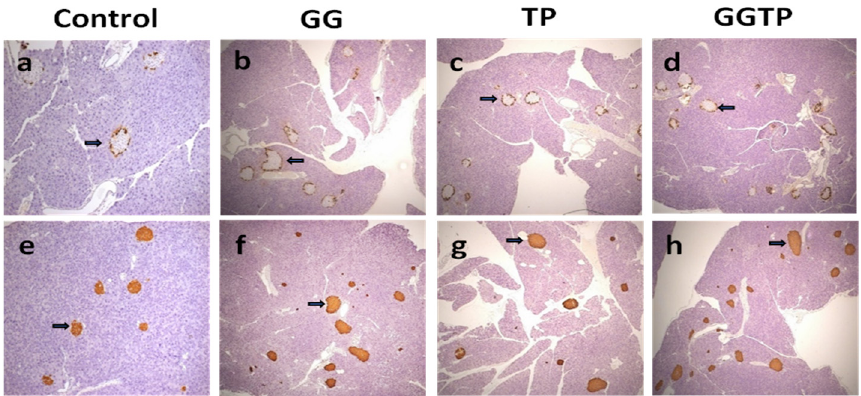
Figure 1. Effect of geranylgeraniol (GGOH) and green tea polyphenols (GTP) on immunohistochemical analysis of pancreatic tissue. Pancreatic tissue sections collected from mice fed HFD ( a , e ), High-fat-diet (HFD) only (control group), HFD supplemented with 400 mg GGOH/kg diet (GG group, ( b , f )), HFD supplemented with 0.5% GTP in drinking water (TP group, c , g ), and HFD supplemented with GGOH and GTP (GGTP group, ( d , f )) were immunostained for glucagon ( a – d ) or insulin ( e – h ) and counterstained with hematoxylin. Group assignment includes control group (high-fat diet group); TP group (high-fat diet and green tea polyphenols at 0.5% ( v / w in drinking water)); GG group (high-fat diet and geranylgeraniol at 400 mg/kg diet); GGTP (high-fat diet, geranylgeraniol, and green tea polyphenols). The arrows in a–d point to glucagon postivie alpha cells. The arrows in e–h point to insulin positive beta cells. The magnification is 10×.